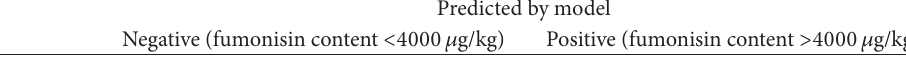
Table 1: Two-way confusion matrix.